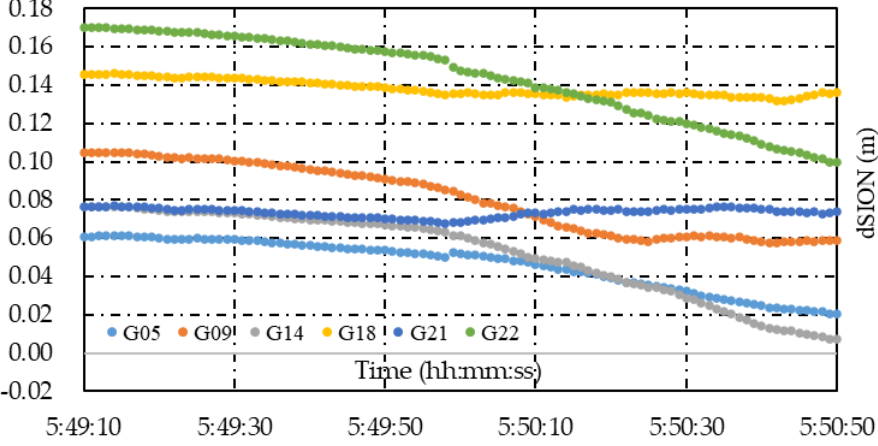
Figure 23. dSIONs between static PPP without and with MSJP corrections.